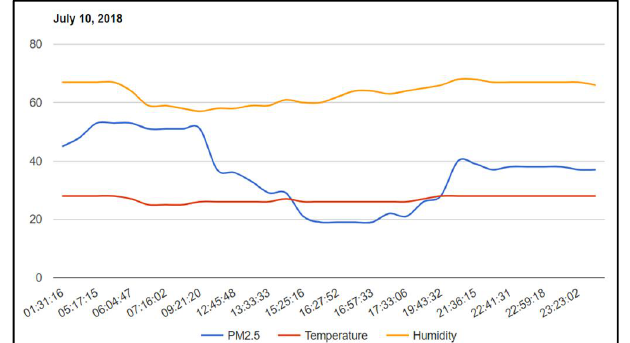
Fig. 9 24-hours chart of PM2.5, temperature, and humidity